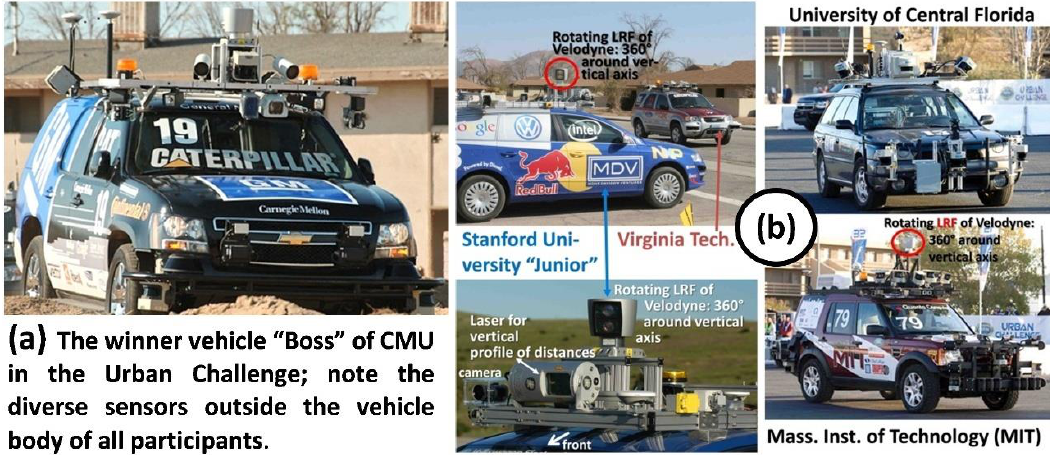
Figure 9. A collection of images to yield an impression of the amount of external sensors used in the Urban Challenge 2007 for perceiving the environment in short and medium range. Note the revolving Laser-Range-Finder on top of all vehicles.